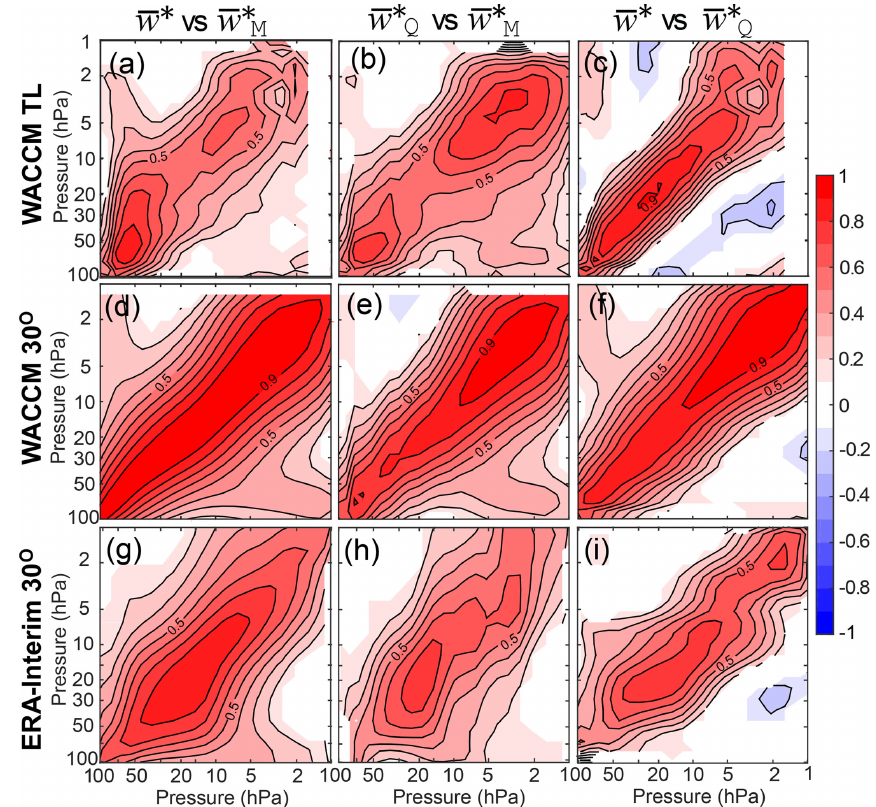
Figure 5. Correlation coefficients ( r ) for the deseasonalized time series of the three different TEM vertical velocities calculated from WACCM (a–f) and for ERA-Interim (g–i) : (a, d, g) ¯ w ∗ vs. ¯ w ∗ the y axis is listed first. (a–c) Averages between the turnaround latitudes and (d–f) averages between 30 ◦ S and 30 ◦ N. Contours are spaced every